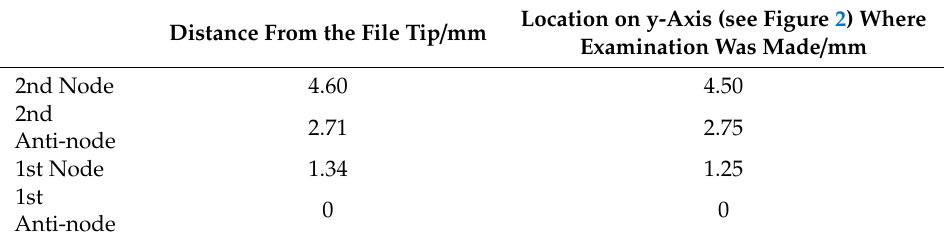
Table 1. Distance of the nodes and anti-nodes from the tip of a no. 15 endosonic file vibrating in water, and the locations where CLSM images were captured after the